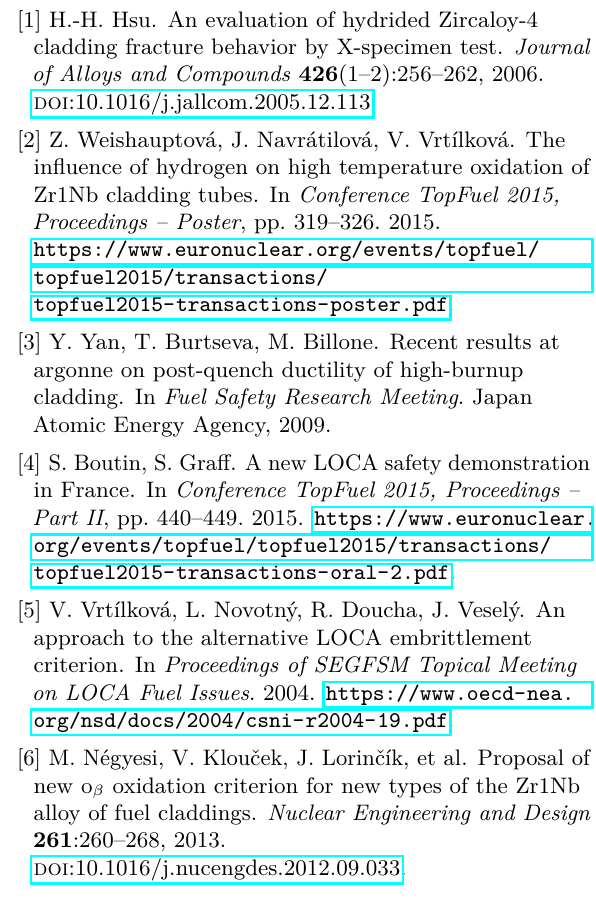
Figure 12. Sample 829 447. After hydrogen charging with inner pressure 3 MPa.